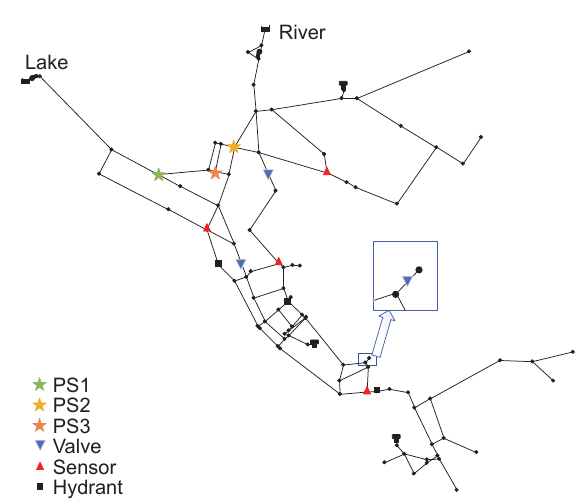
Fig. 4 Three single pollution events PS1, PS2, and PS3.